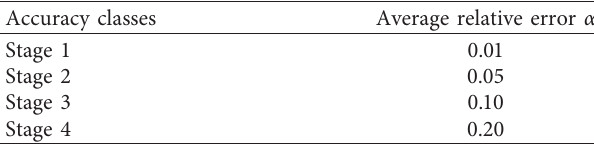
Table 1: Continuous interval sequence error test table.